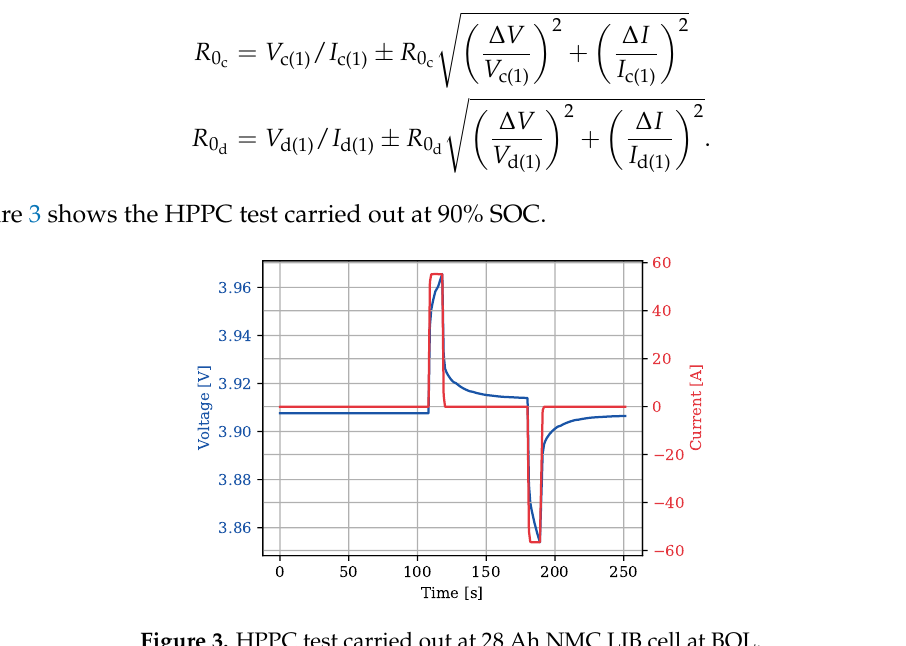
Figure 3. HPPC test carried out at 28 Ah NMC LIB cell at